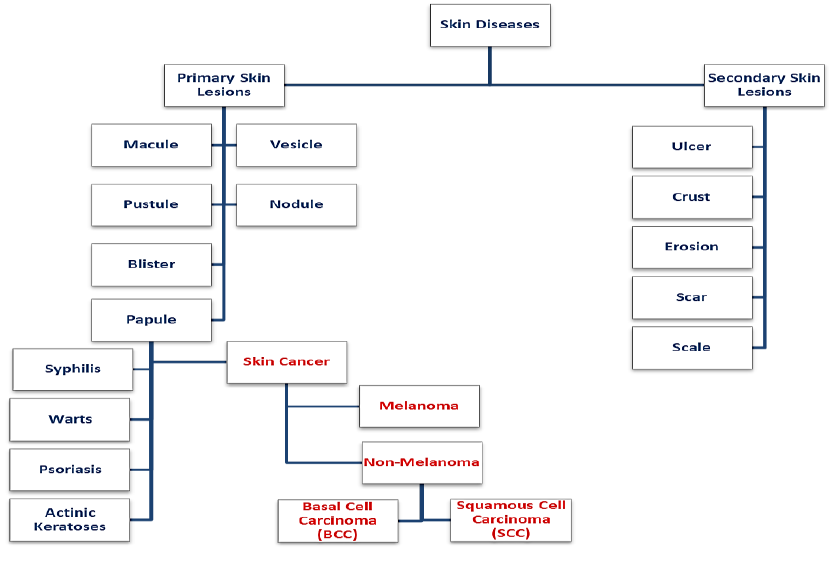
Figure 1. Types of Skin Diseases.